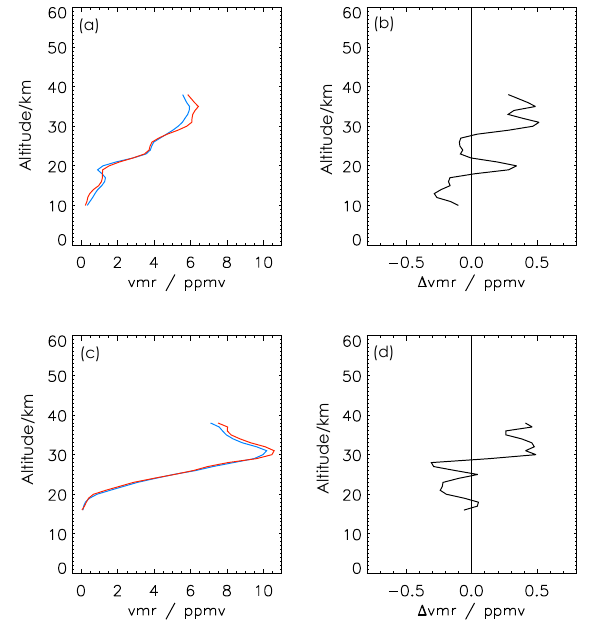
Figure 4. (a) Ozone profiles retrieved from MIPAS-balloon measurements above Esrange (67.9 ◦ N, 21.1 ◦ E), Sweden, on 31 March 2011, using microwindows in MIPAS channels A (blue) and AB (red). (b) Difference between retrievals using microwin- dows in MIPAS channels AB and A. (c) Same as (a) but for MIPAS- balloon measurements above Teresina (5.1 ◦ S, 42.9 ◦ W), Brazil, on 14 June 2005. (d) Differences between the ozone profiles result- ing from use of the modified and the original HITRAN-2008 spec-